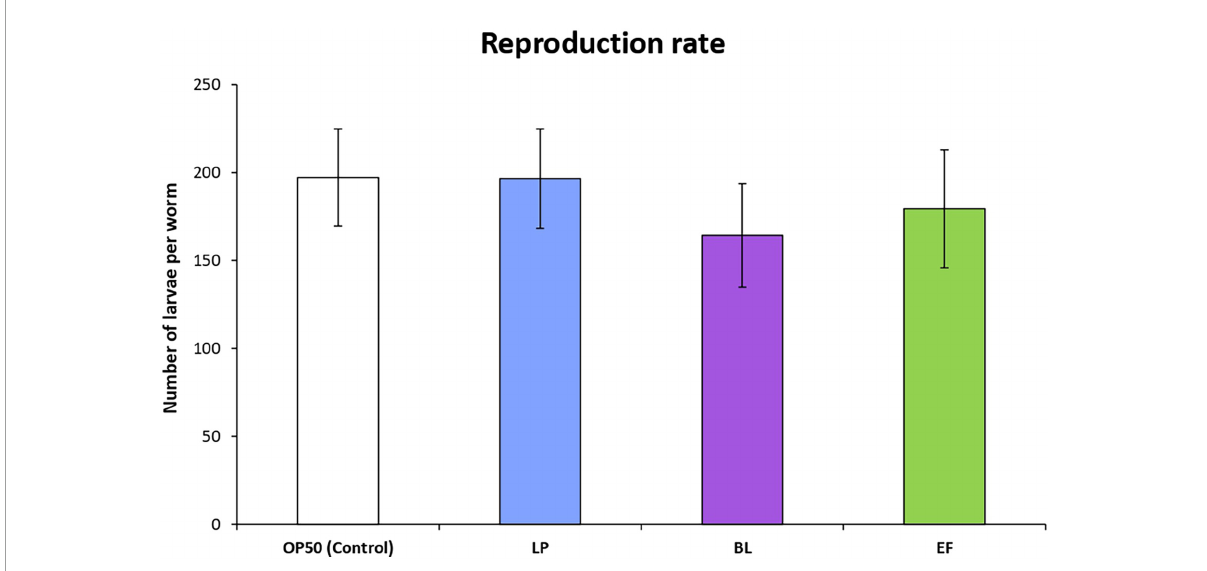
FIGURE2 Influence of Lactobacillus plantarum CLC17 (LP), Bifidobacterium longum NCIMB 8809 (BL), Enterococcus faecium CECT 410 (EF) and E. coli OP50 (control) in the reproduction rate of C. elegans. The error bars represent standard deviation ( n = 30 worms). No significant differences among worms cultivated with the different bacteria were observed ( p <